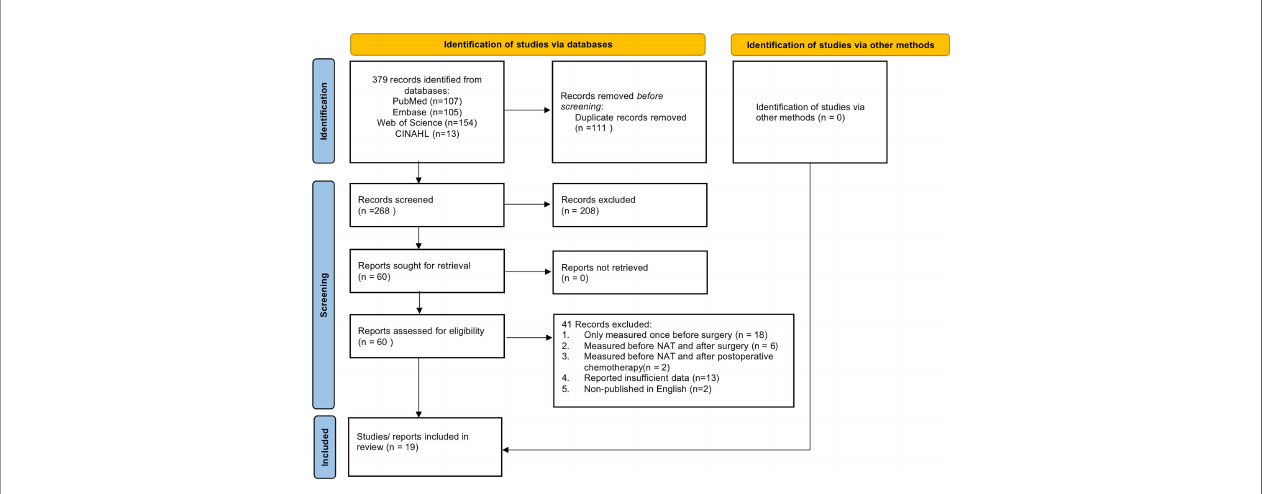
FIGURE 1 | The fl ow diagram of the study selection